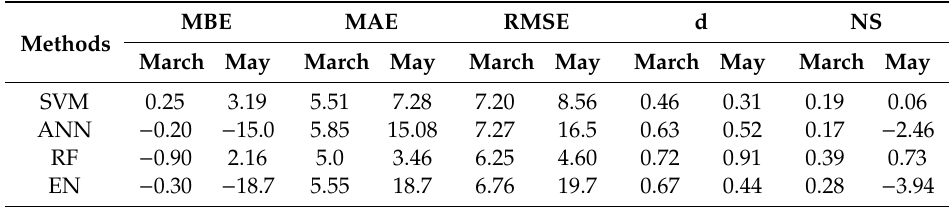
Table 4. Prediction error metrics of the ANN, SVM, RF, and Elastic Net regression. 7 March 2017 10-fold cross-validation dataset, and 26 May 2017 external testing datasets.